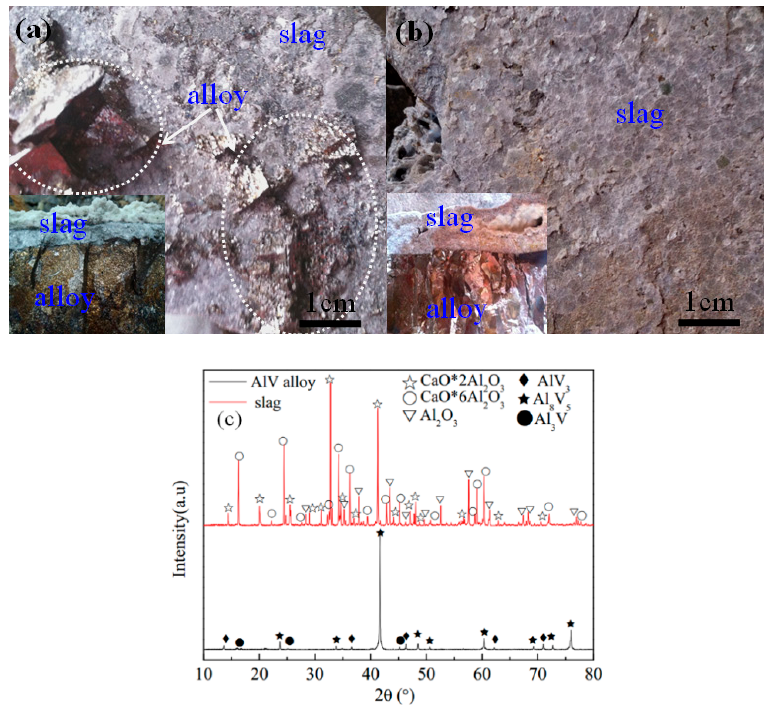
Figure 4. ( a ) Photograph of the alloy and the slag (heating time = 0 min); ( b ) photograph of the alloy and the slag (heating time = 10 min); ( c ) XRD patterns of the products obtained after reaction ( M Al : M V2O5 = 0.96:1; heating time = 10 min).